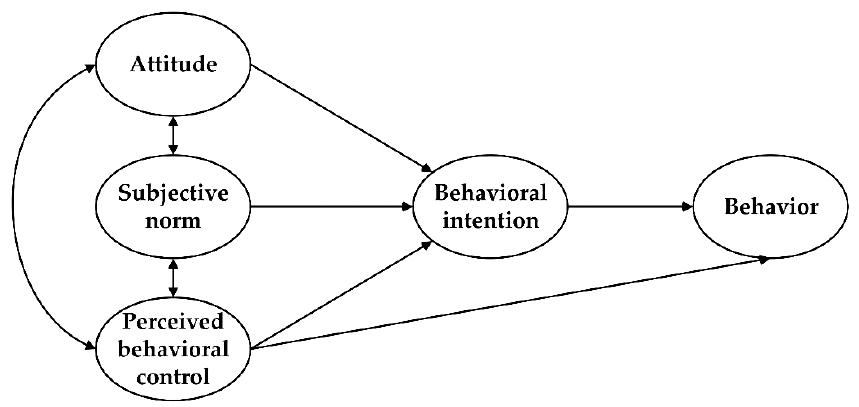
Figure 1. The theory of planned behavior.